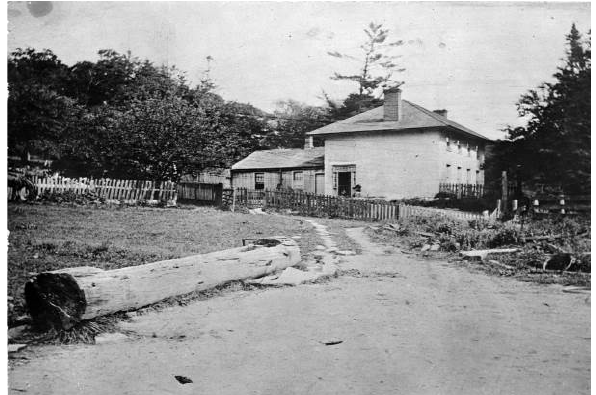
Figure 10: Helliwell, Thomas, house, Pottery Rd., south side, east of Don R., Toronto, Ont., Unknown, Picture, 187- (Source: Courtesy of Toronto Public